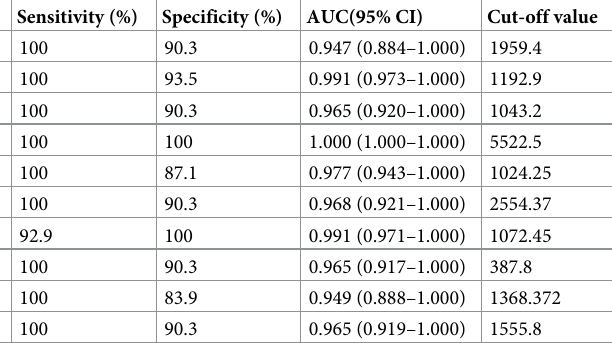
Table 2. The sensitivity and specificity of the 10 hub genes in detecting DM. Rank Gene symbol The name of